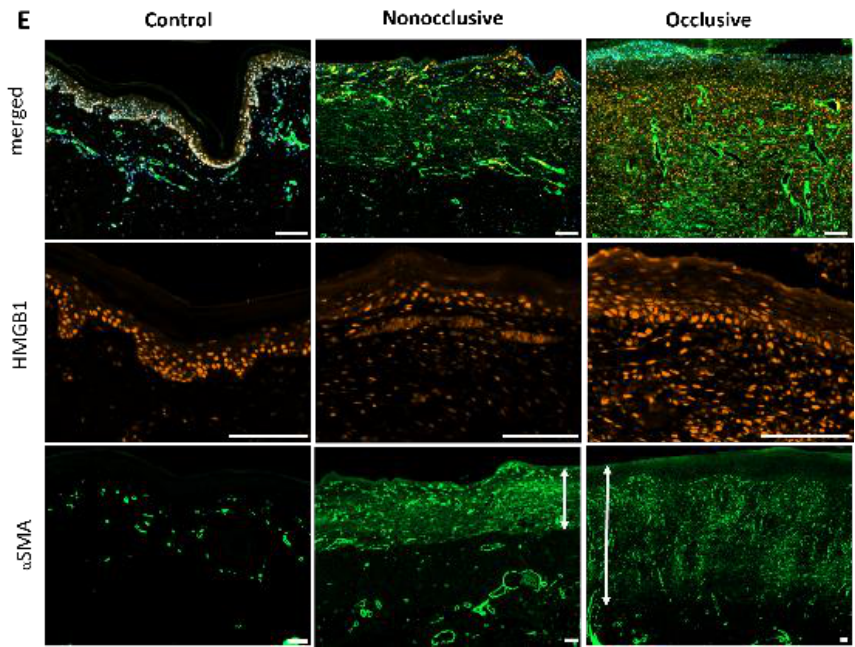
Figure 4. Wound healing process of the tissue after seven days of treatment. Percentage re-epithelialization for nonocclusive and occlusive dressings ( A ) and average thickness of new dermal tissue ( B ) obtained by the analysis of H&E staining. H&E staining ( C ) and immunofluorescence staining for anti-α-smooth muscle actin (αSMA, green) ( D ) of wounds treated with occlusive and nonocclusive secondary wound dressing. Red and white arrowheads indicate the epidermis on top and the end of regenerated dermis at the bottom. The scale bar represents 200 µm. Immunofluorescence staining of skin untreated and treated with nonocclusive and occlusive secondary dressings. Merged images labeled with DAPI (blue), high mobility group protein B1 (HMGB1, red), and αSMA (green) showed a staining pattern for the untreated skin (control) and the wounded skin treated with nonocclusive and occlusive dressing. HMGB1 staining showed undamaged cells under both treatments in comparison with the control group. αSMA staining revealed the presence of vessels in the tissue. The vertical doubled arrow lines indicate the thickness of regenerated dermal tissue containing activated myofibroblasts for both treatments ( E ). p values: ***: 0.0008; ****: < 0.0001. Scale bar: 100 µm.